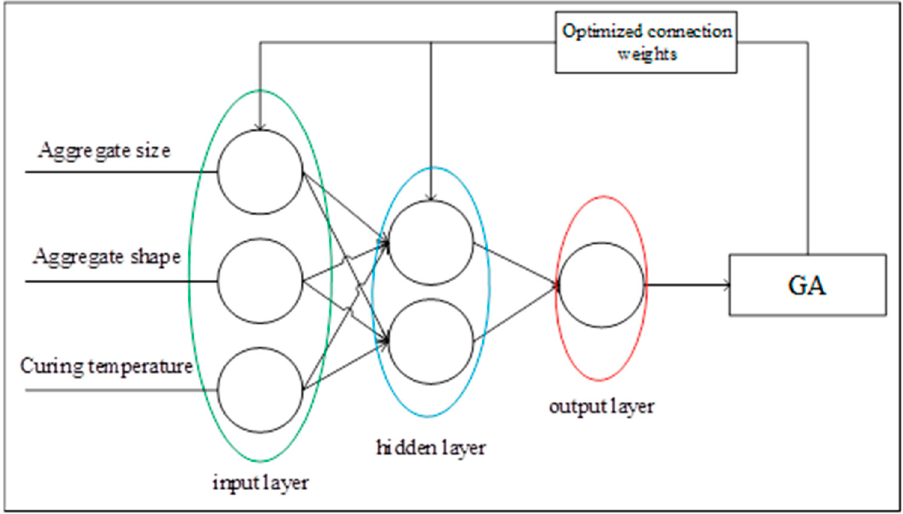
Figure 7. The general framework of neural network and weight correction by genetic algorithm.